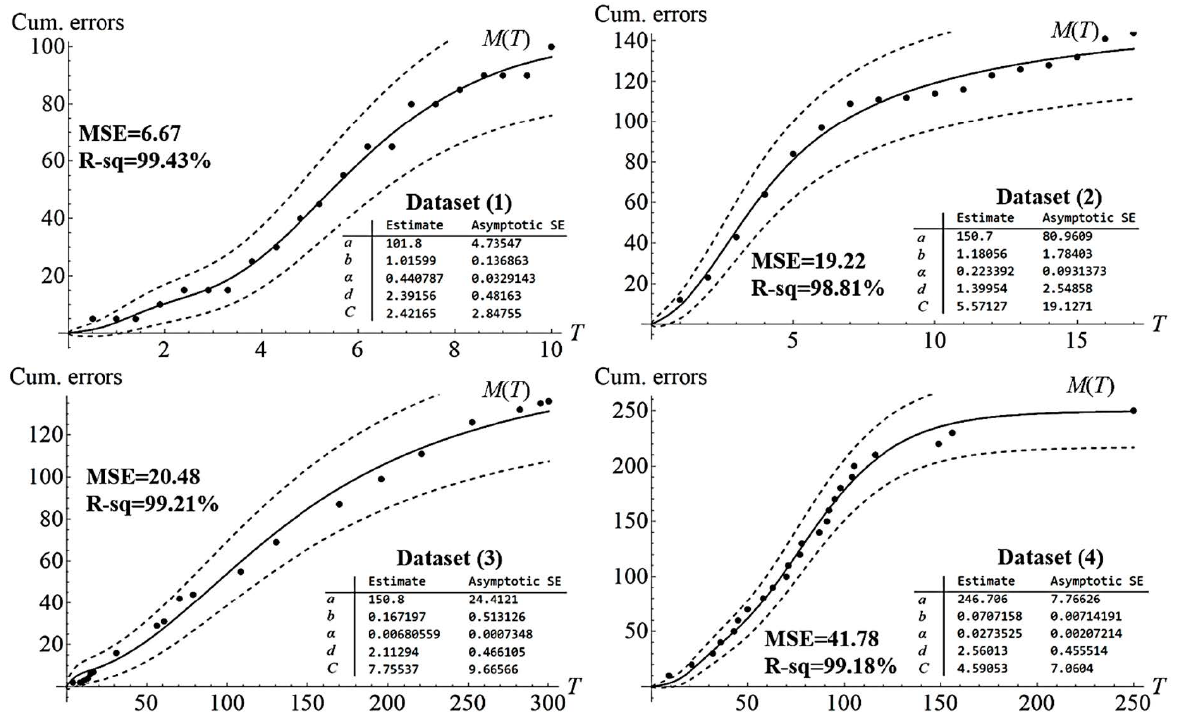
Figure 4. The fitting results and parameter estimation for Wang’s model.